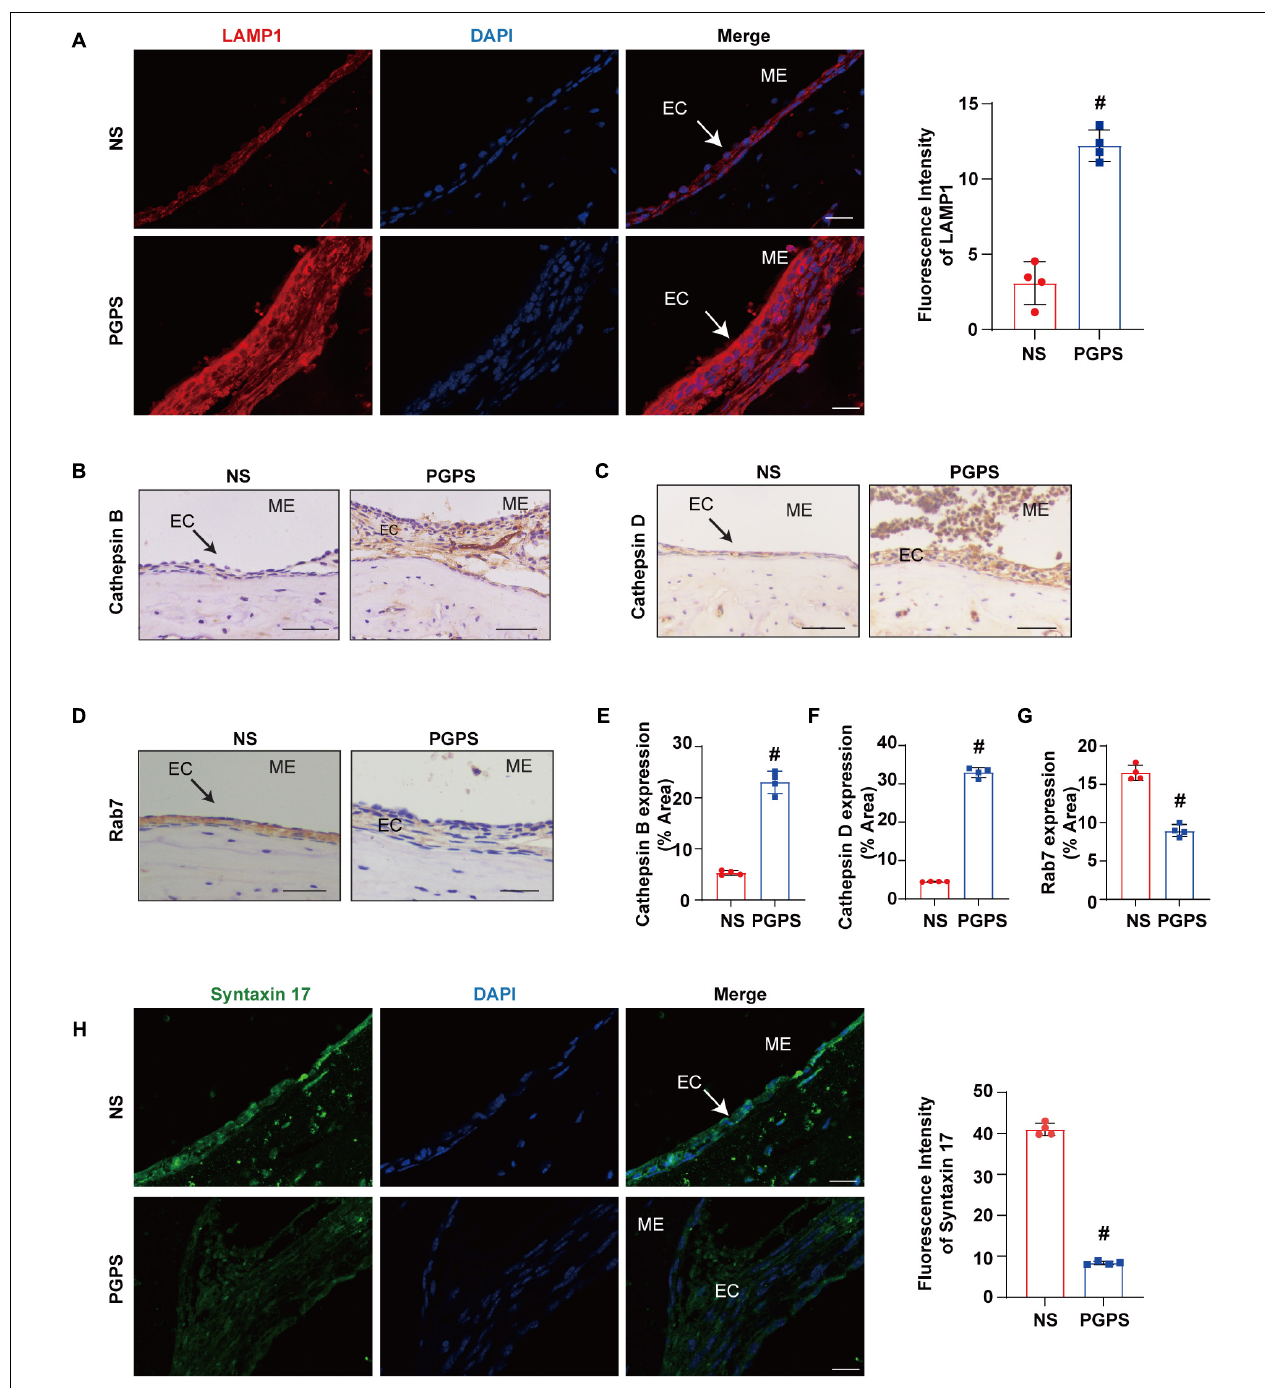
FIGURE 4 | Peptidoglycan-polysaccharide induces obstacles to the fusion of autophagosomes and lysosomes in OM mice. Mice were inoculated with NS or PGPS for 3 days. Paraffin-embedded sections of ME tissues were immunostained with antibodies. (A) The representative images and quantification of LAMP1 expression in ME tissues. (B) The representative images of Cathepsin B expression in ME tissues. (C) The representative images of Cathepsin D expression in ME tissues. (D) The representative images of Rab7 expression in ME tissues. (E) The quantification of Cathepsin B expression in ME tissues. (F) The quantification of Cathepsin D expression in ME tissues. (G) The quantification of Rab7 expression in ME tissues. (H) The representative images and quantification of Syntaxin 17 expression in ME tissues. # P < 0.05 vs. NS group, n = 4 per group, Student’s t -test. ME represents the middle ear; EC represents epithelial cells. Scale bar = 25 µ m.